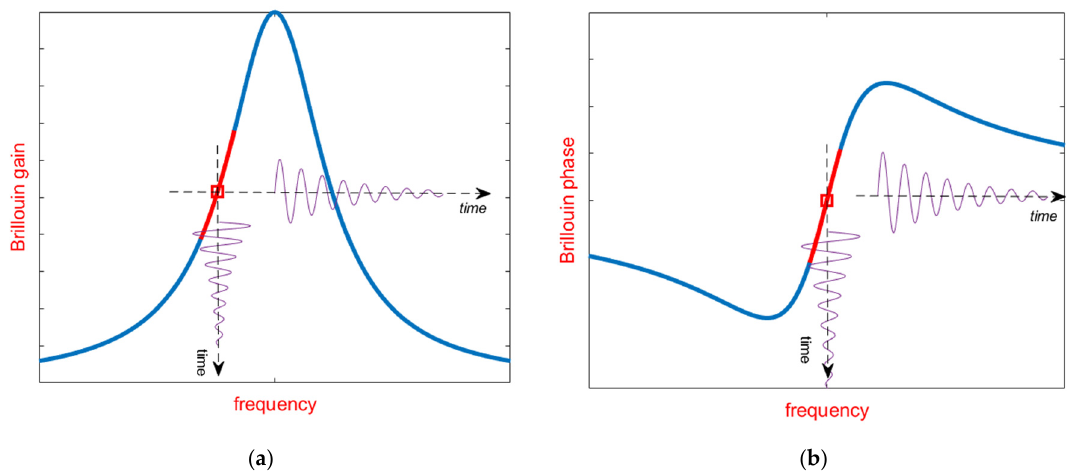
Figure 5. Principle of operation of the SA-BOTDA method: the strain-induced spectral shifts of the BGS ( a ) or the BPS ( b ) can be regarded as temporal variations of the probe frequency around its working point.